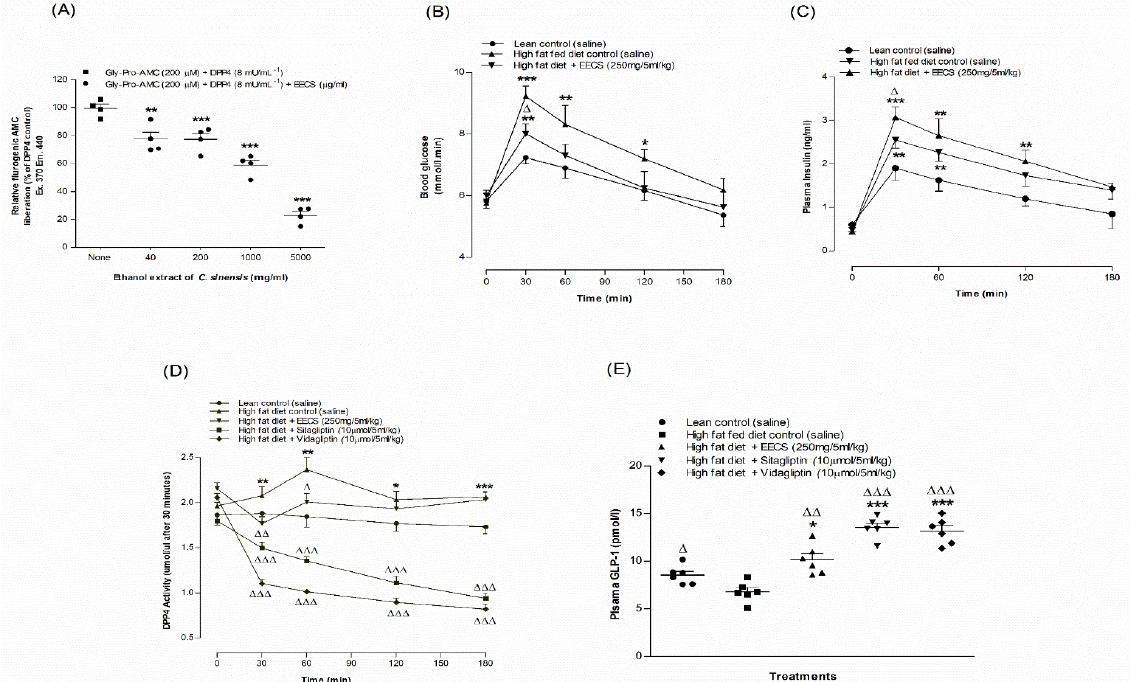
Figure 3. Effects of EECS on ( A ) DPP-IV enzyme in vitro, ( B ) glucose tolerance, ( C ) plasma insulin, ( D ) DPP-IV and ( E ) active GLP-1 (7–36) in high-fat-diet-fed rats. In vivo parameters were evaluated before and after oral administration of glucose alone (18 mmol/kg body weight, control) or with EECS (250 mg/5 mL/kg body weight), sitagliptin and vidagliptin (both at 10 μ mol/5 mL/kg, body